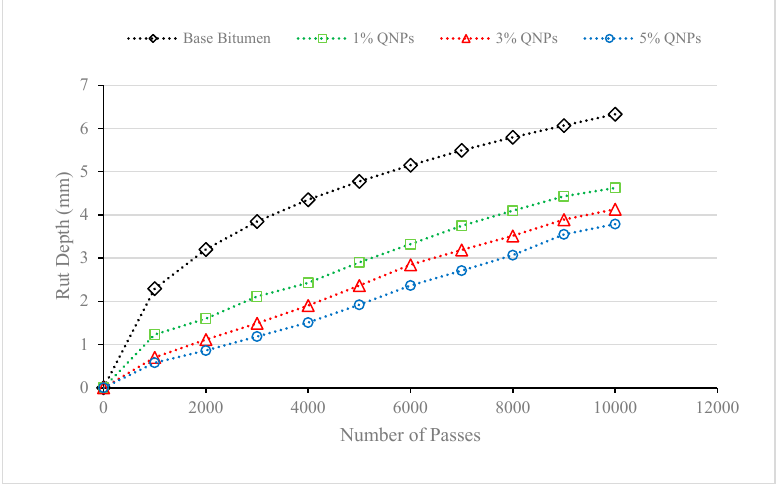
Figure 18. Permanent deformation at 55 °C for base and QNP ‐ modified (1%, 3% and 5%) bitumen.